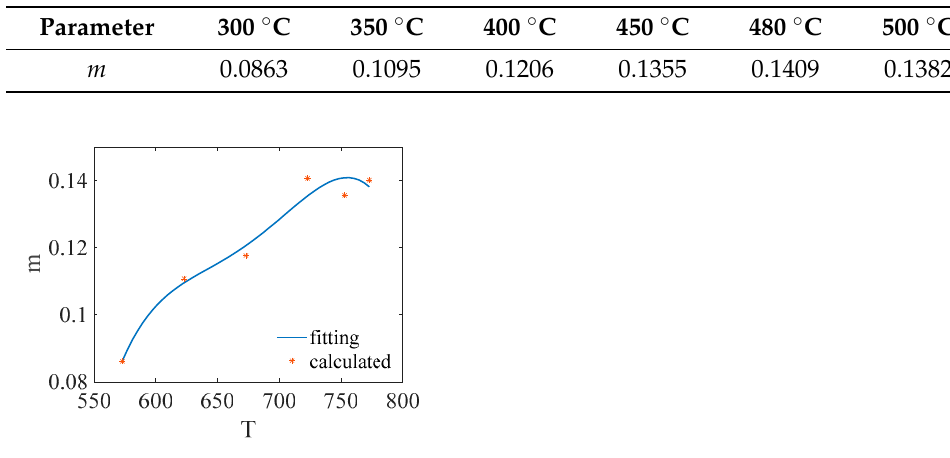
Table 6. The value of parameter m at different temperatures.